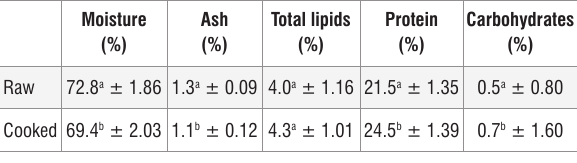
Proximate composition (% mean ± standard deviation) of raw and cooked † Cape snoek ( Thyrsites atun ) muscle Moisture Ash (%) (%)